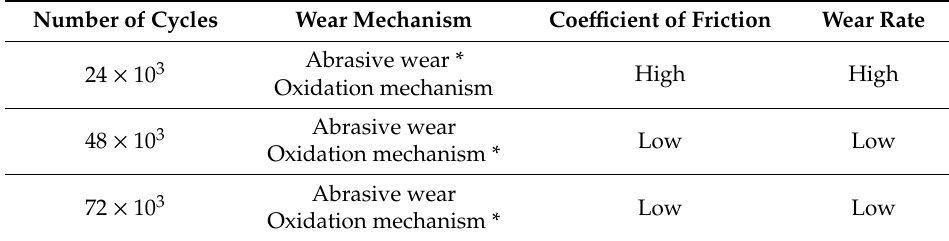
High High Low Low Low